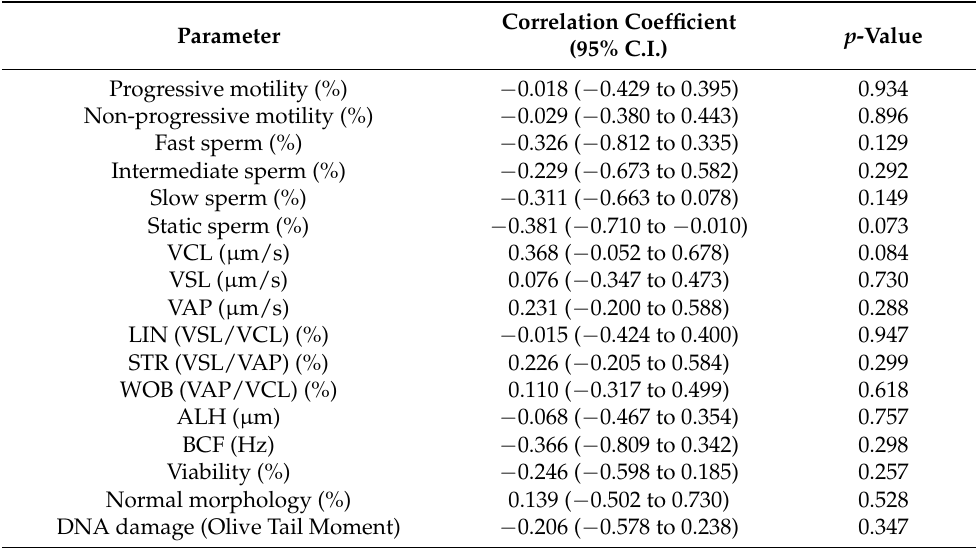
Table 2. Correlation coefficients and the corresponding p -values between sperm telomere length and quality parameters.